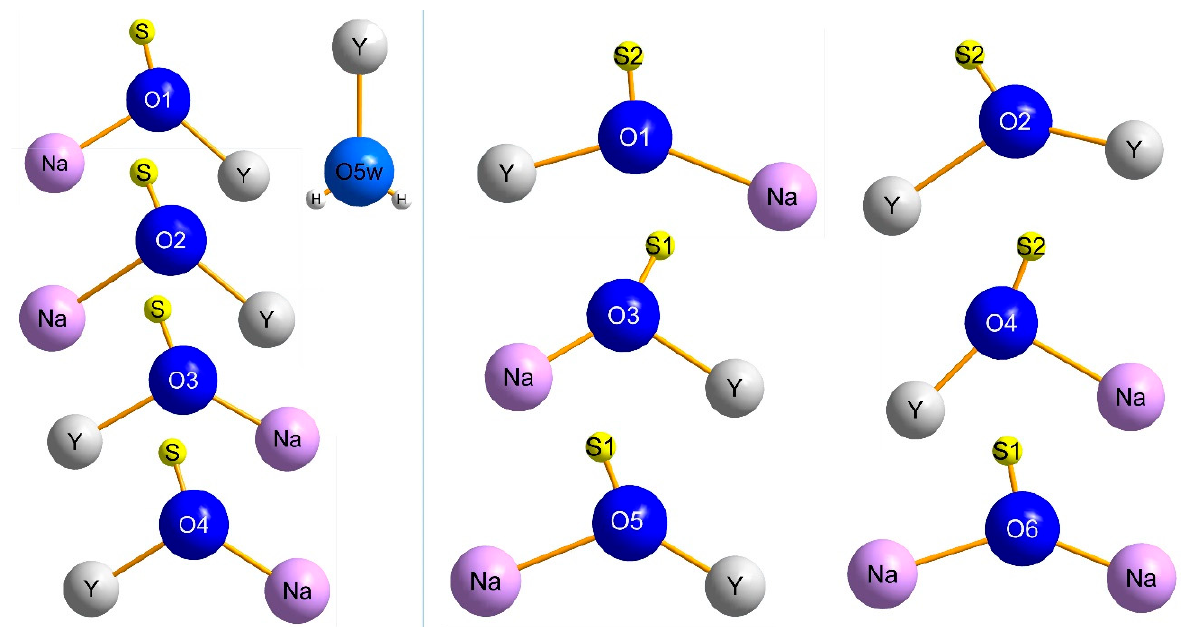
Figure 7. Coordination spheres of the tetrahedral oxosulfate anions [SO 4 ] 2– in NaY[SO 4 ] 2 ∙ H 2 O ( left ) and NaY[SO 4 ] 2 ( right ).